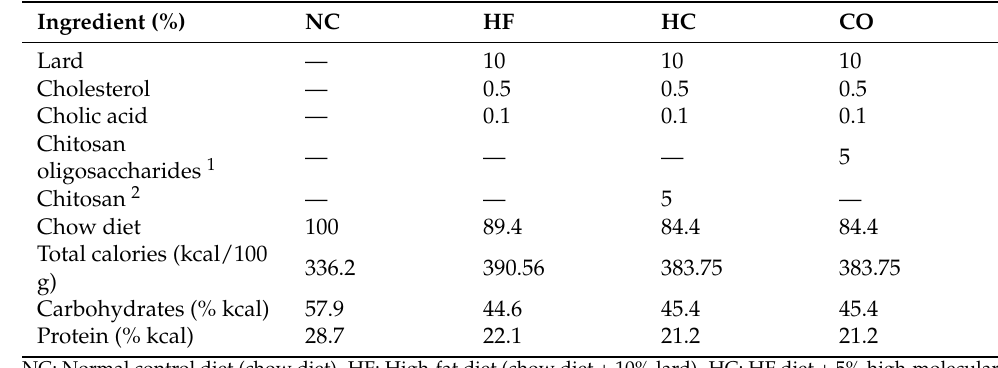
Table 6. Composition of experimental diets